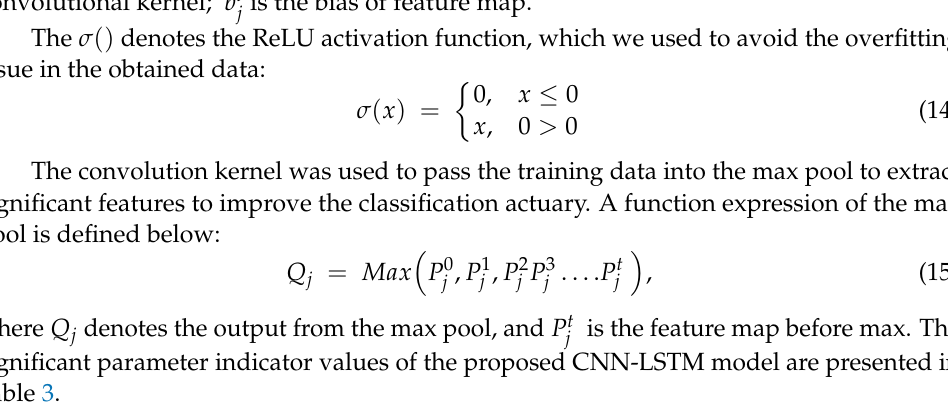
Table 3. Parameter values of the proposed CNN-LSTM model. #Parameters Indicators